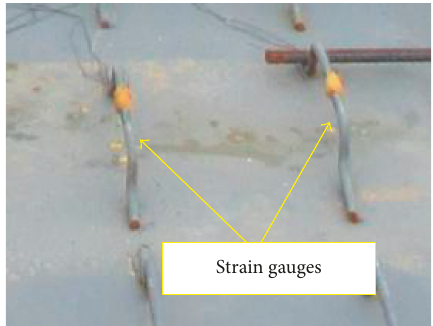
Figure 11: Strain gauges on the bent